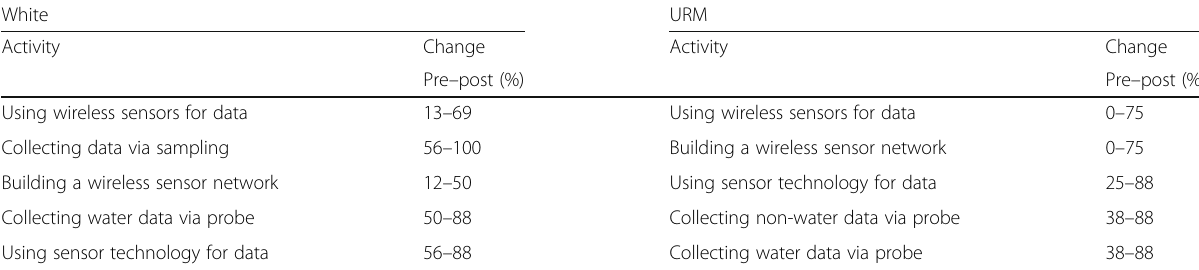
Table 4 The top five activities with the greatest increase in average participation rates for white and URM students (2014 – 2015 cohort, as given in Table 2)